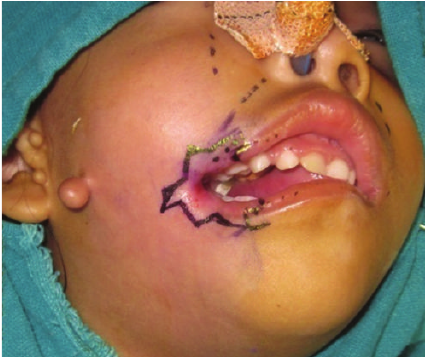
Figure 2: Photograph showing marking for the vermilion